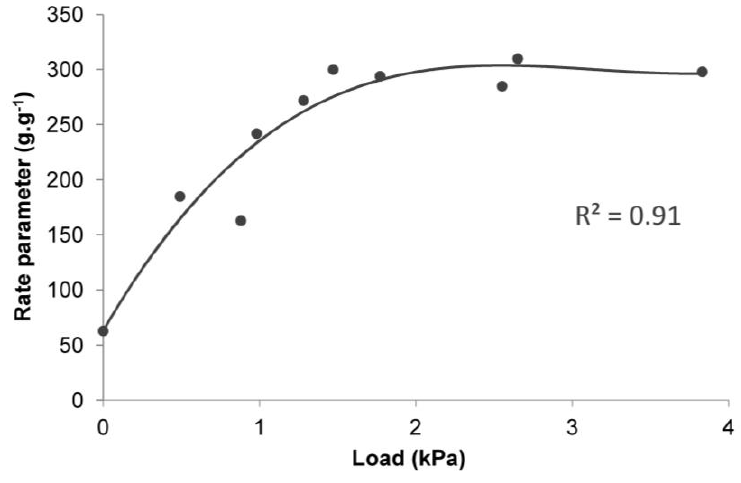
Figure 9. The dependence between the swelling rate parameter ( τ ) and the load for all test groups and the control.